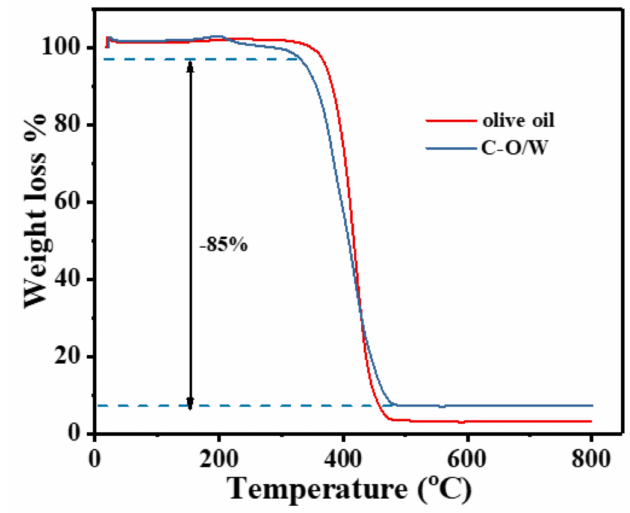
Figure 5. TGA curves of C–O/W microcapsules and olive